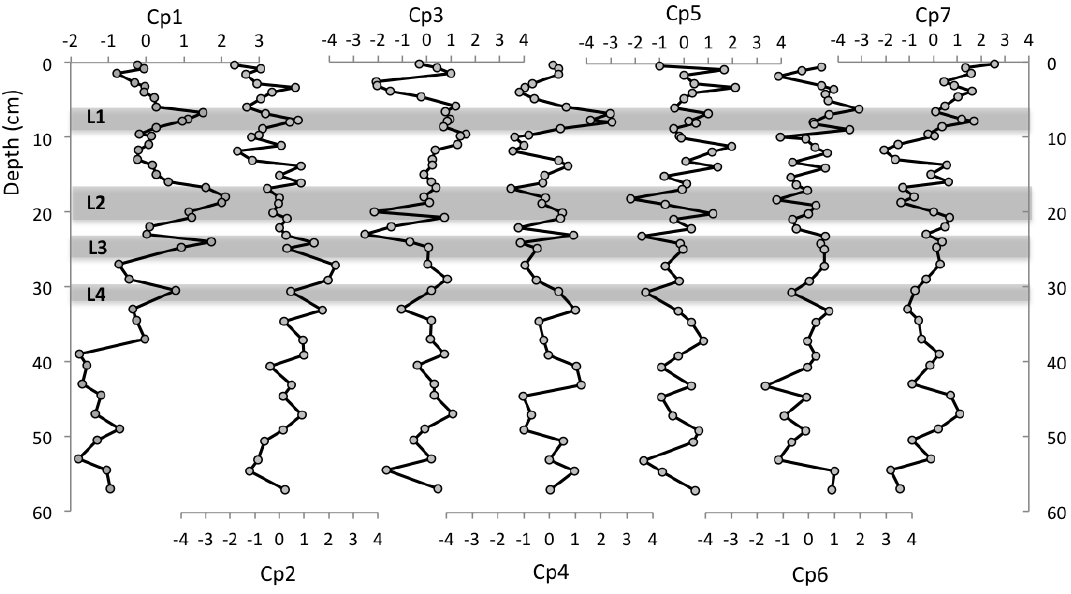
Figure 3. Depth records of scores of the principal components extracted by PCA on the elemental composition of the sediments of the core LIM03/1 of Limnopolar Lake. L1 to L4: layers enriched in Ca, Ti, Zr, and Sr, which are interpreted as tephras.